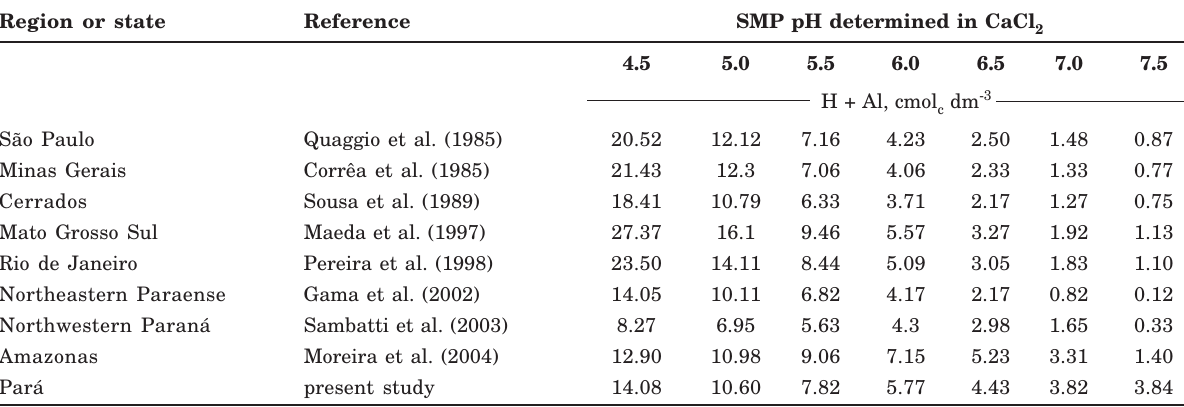
Table 2. Comparison of estimates of H + Al levels in soils in the State of Pará, with SMP pH between 4.5 and 7.3, based on equations adapted for different states and regions of Brazil